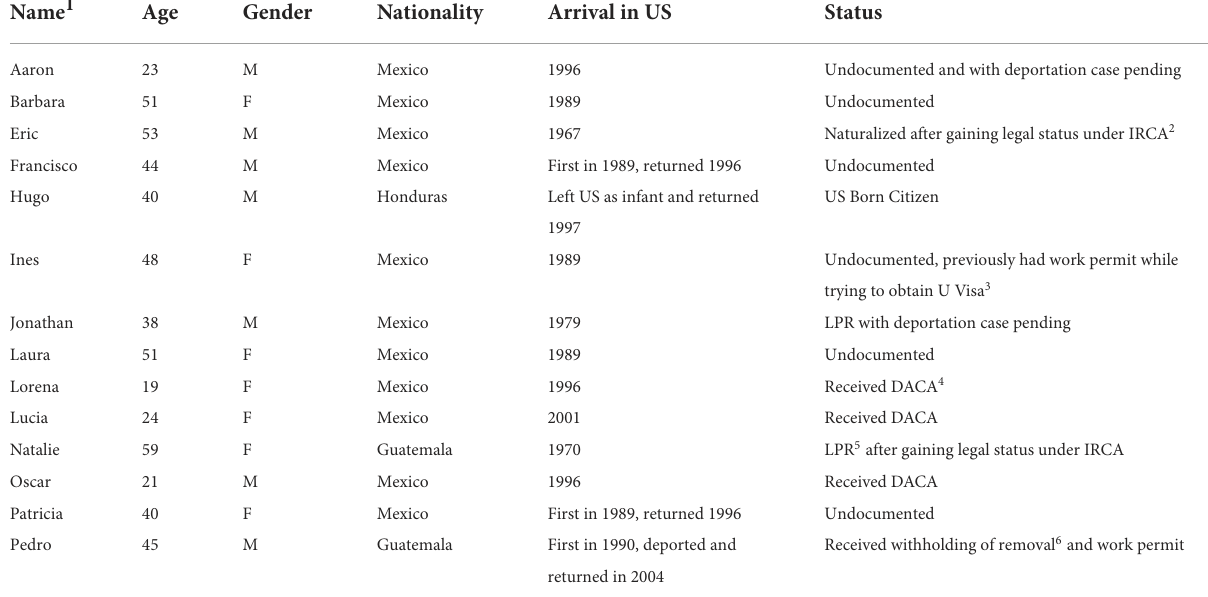
TABLE 1 Characteristics of